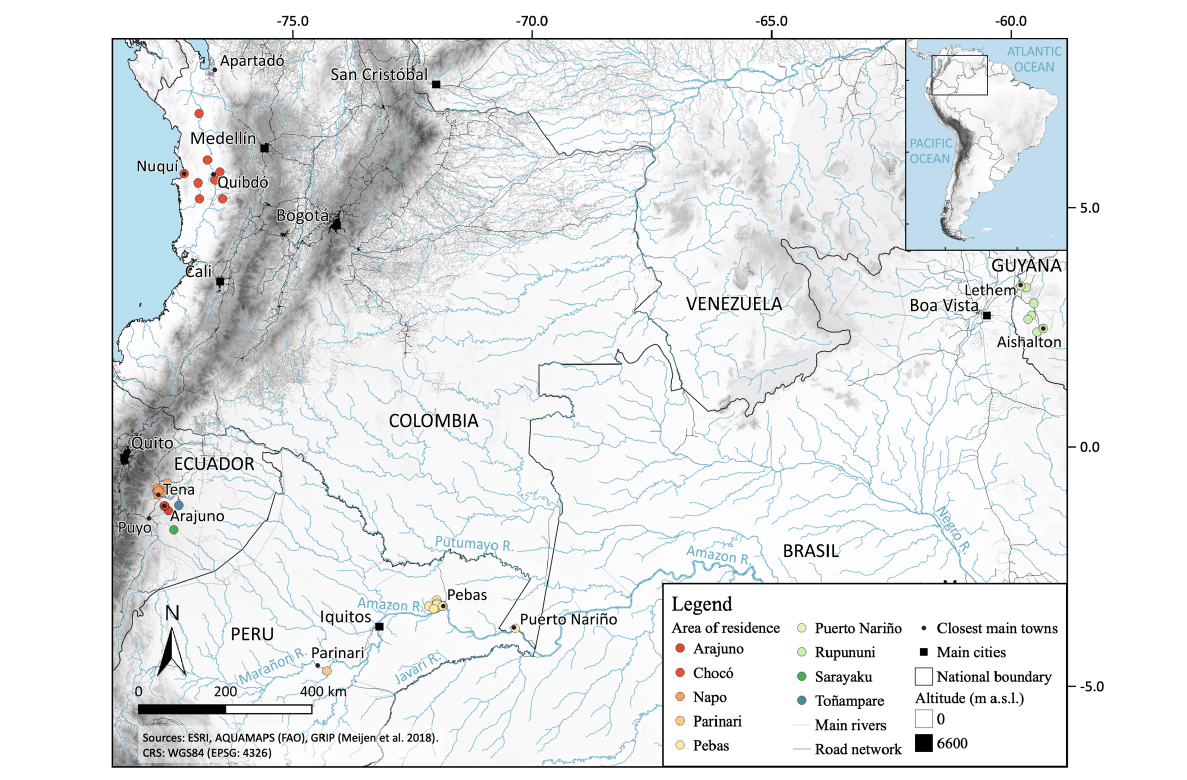
Fig. 1 . Geographic location of the 60 villages where the survey was carried out. These were pooled into nine sites for posterior analysis (see text for